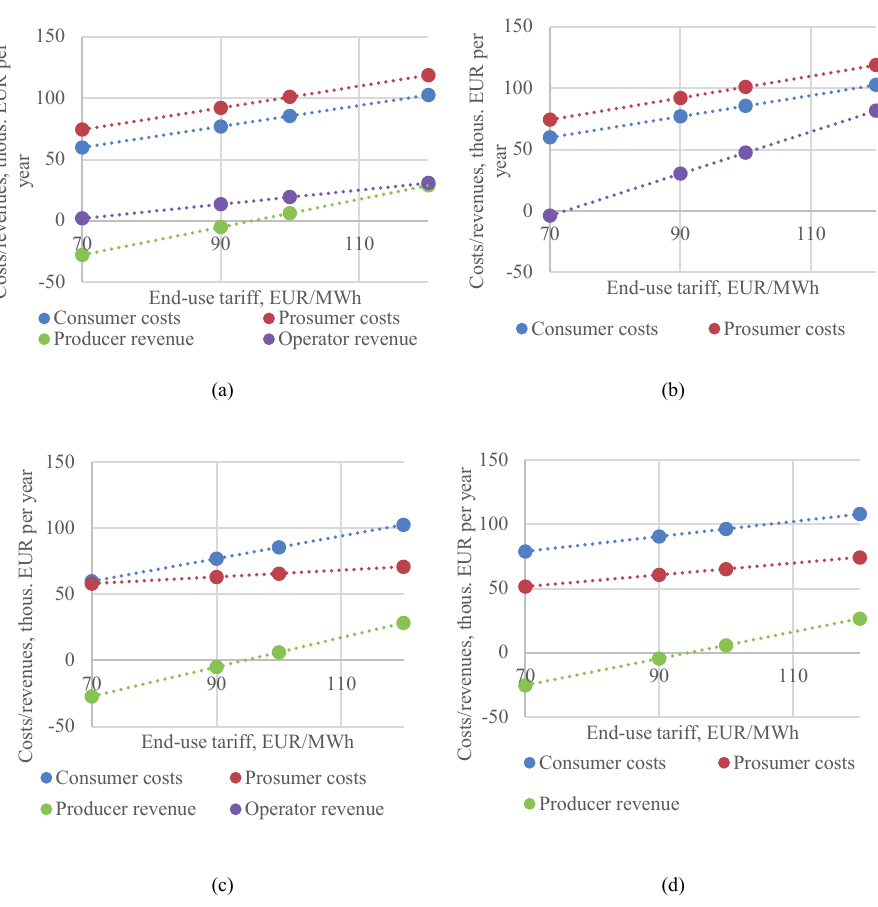
Fig. 7. Changes in main costs and revenues under various end-use heat tariff assumptions: a) Scenario 1a; b) Scenario 1b; c) Scenario 2; d) Scenario